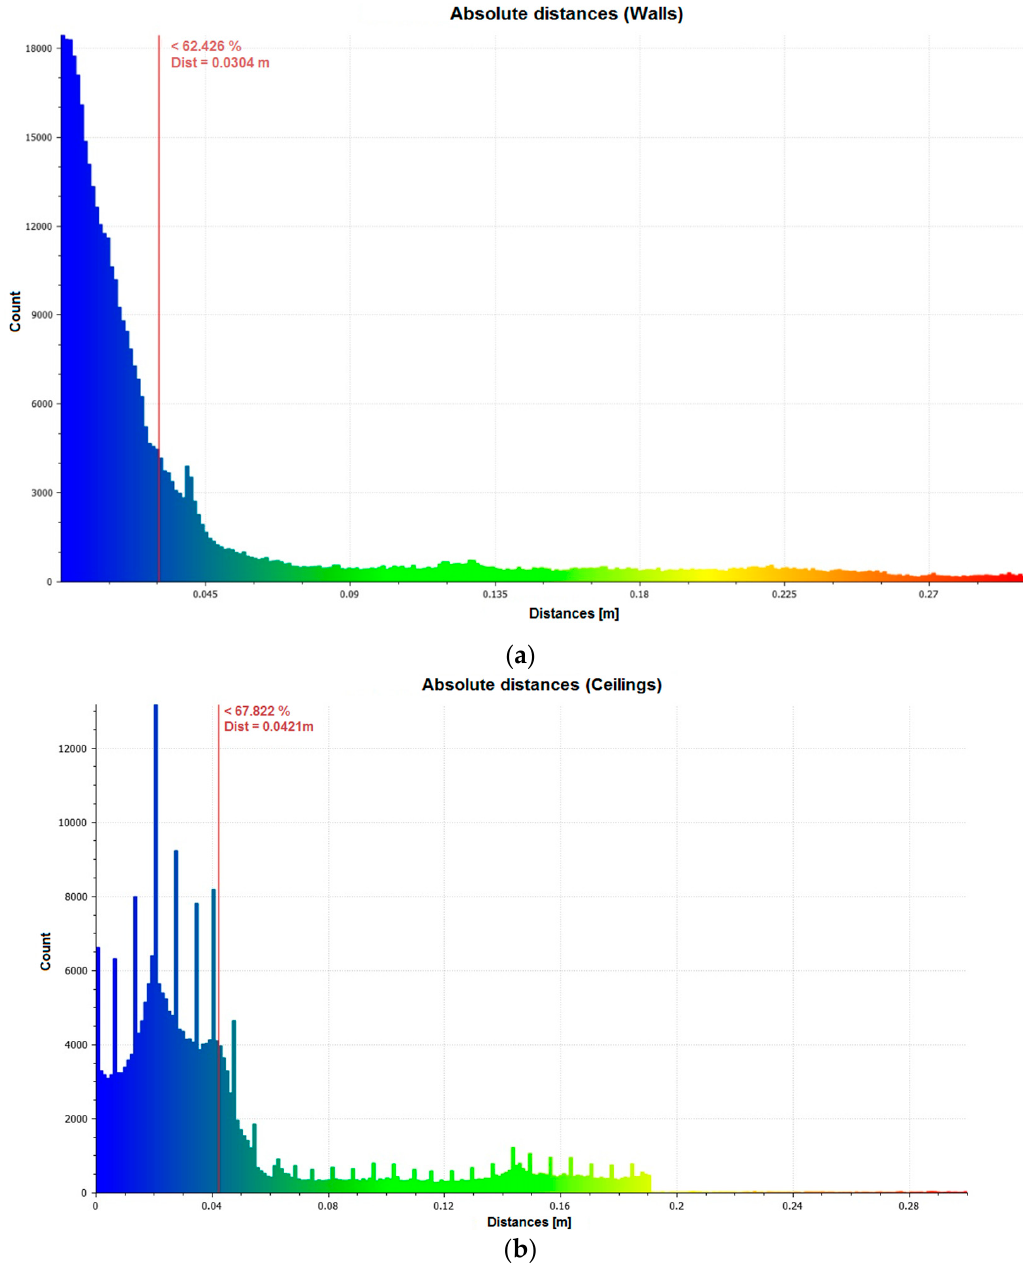
Figure 14. Histogram of residuals between the reconstructed model and point cloud for walls ( a ) and ceiling ( b ).